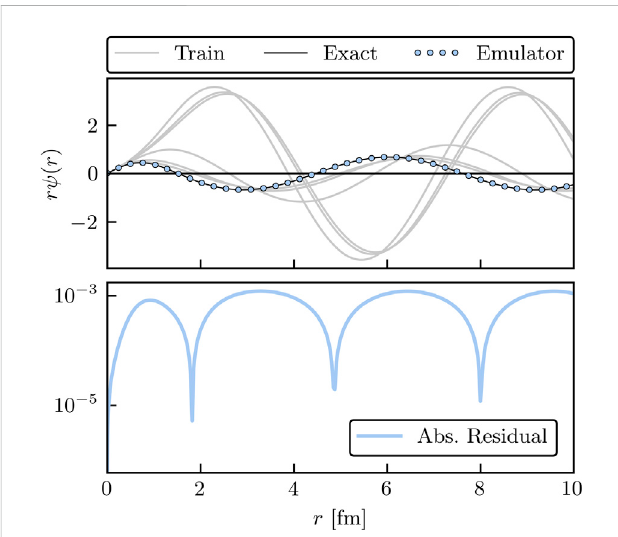
FIGURE 8 Results for the scattering emulator with origin boundary conditions in arbitrary units. Six basis functions are shown as gray lines, and the exact wave function as a black line. Each of the basis functions and the emulated wave function satisfy the constraints at the